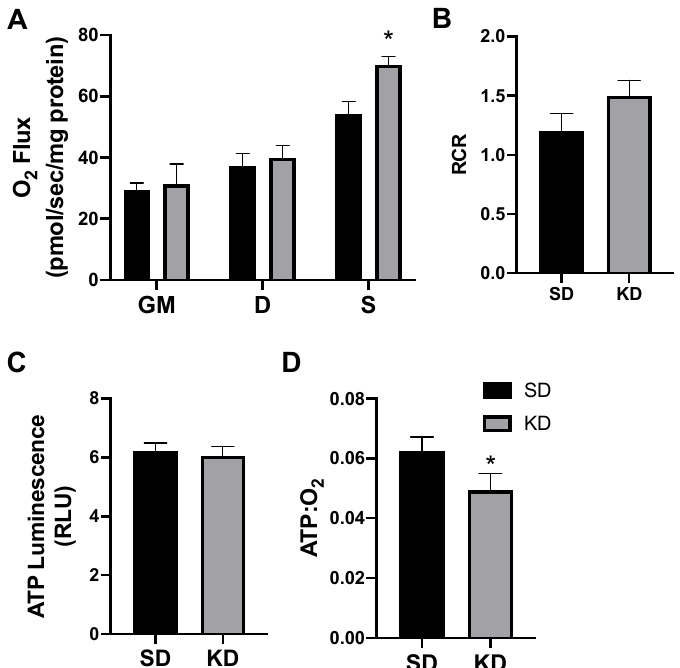
Figure 4. A ketogenic diet minimally alters rodent interscapular adipose mitochondrial bioenergetics. Following the 28-day diet intervention, the interscapular fat was harvested and permeabilized to measure the mitochondrial respiration ( A ) and respiratory control ratio (RCR; B ). ATP was measured via luminescence from fresh tissue ( C ), and the ratio of ATP and oxygen respiration was quantified ( D ). n = 6. * p < 0.05.